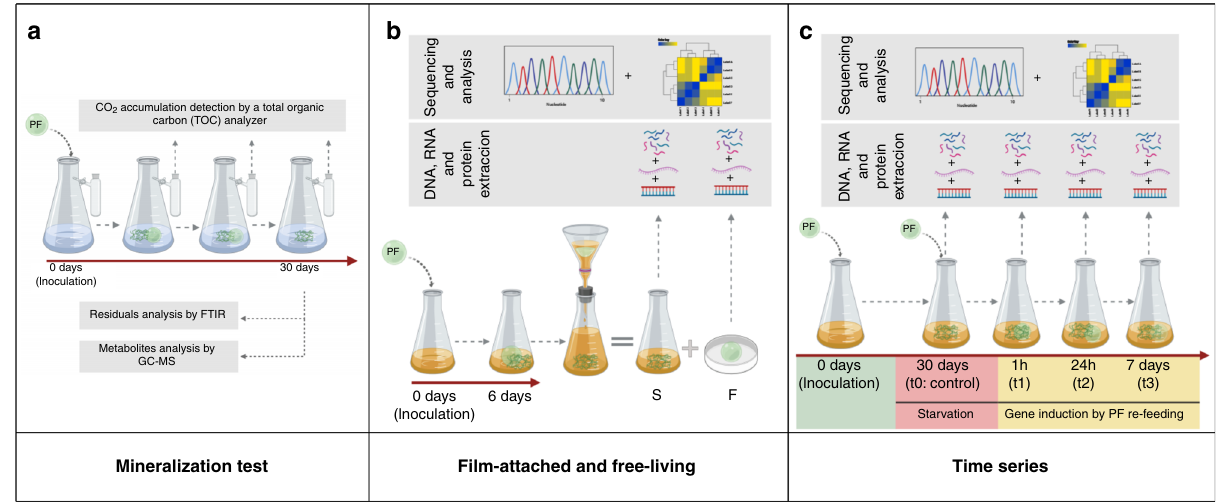
Fig. 1 Experimental setup. a Analysis of plastic-carbon use by measuring CO 2 production in the presence of PF, ( b ) diversity of bio fi lms tested on PF- attached (F) against free-living bacteria (S), ( c ) gene expression and protein biosynthesis of catabolic genes during different time points (t1, t2, t3) relative to a control (t0) in the presence of PF. a , b , c experiments were performed independently from each other and each experiment consisted of three biological replicates (created with